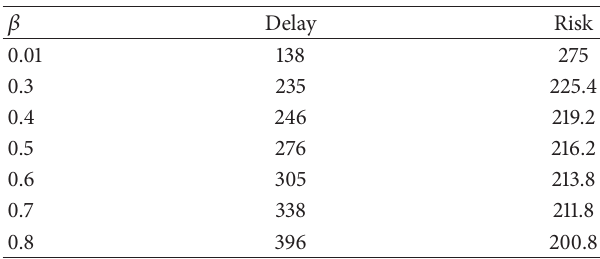
Table 1: 𝛽 versus delay and